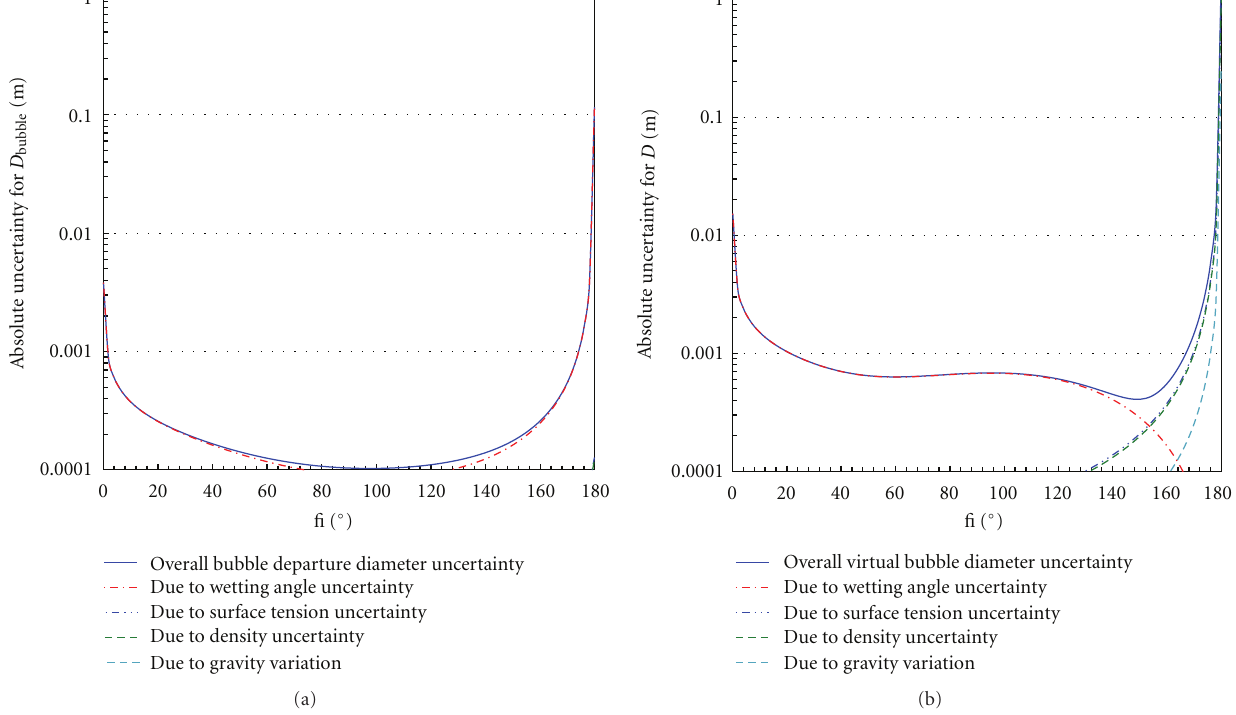
Figure 5: Calculated uncertainty values for bubble departure diameter (a) and the diameter of the virtual sphere defined by the spherical cup